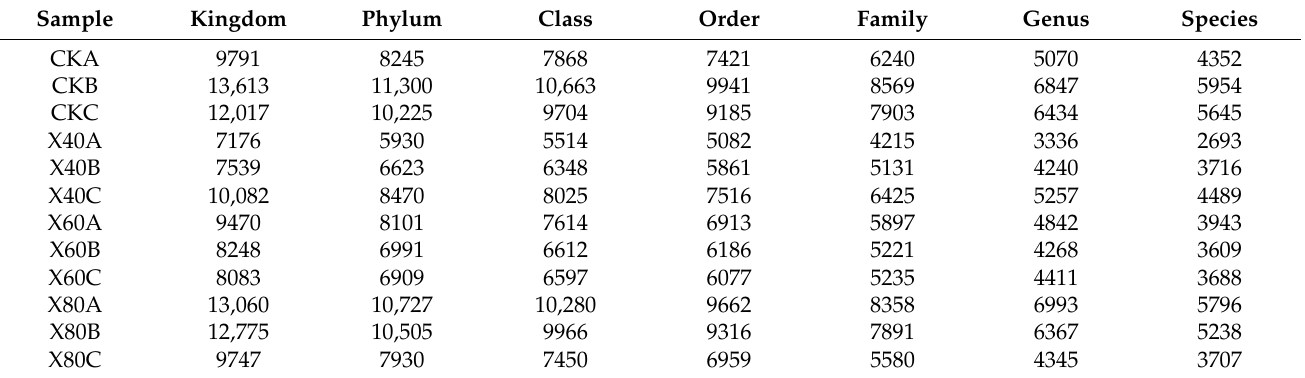
Table 4. Statistics of tags in each rank in rhizosphere soil samples of L. barbarum among different root-restriction